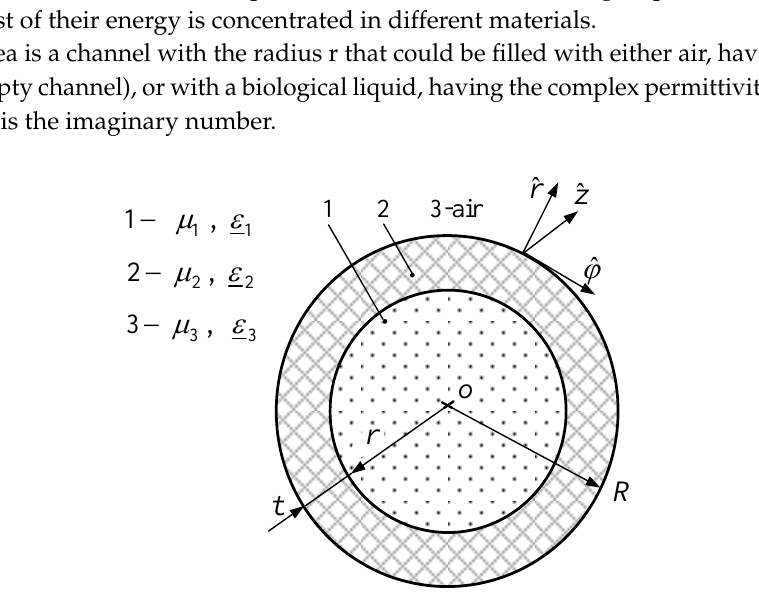
Figure 1. The tube waveguide with a central channel. The tube waveguide consists of: 1 — biological substances, 2 — external dielectric layer, and 3 — air.